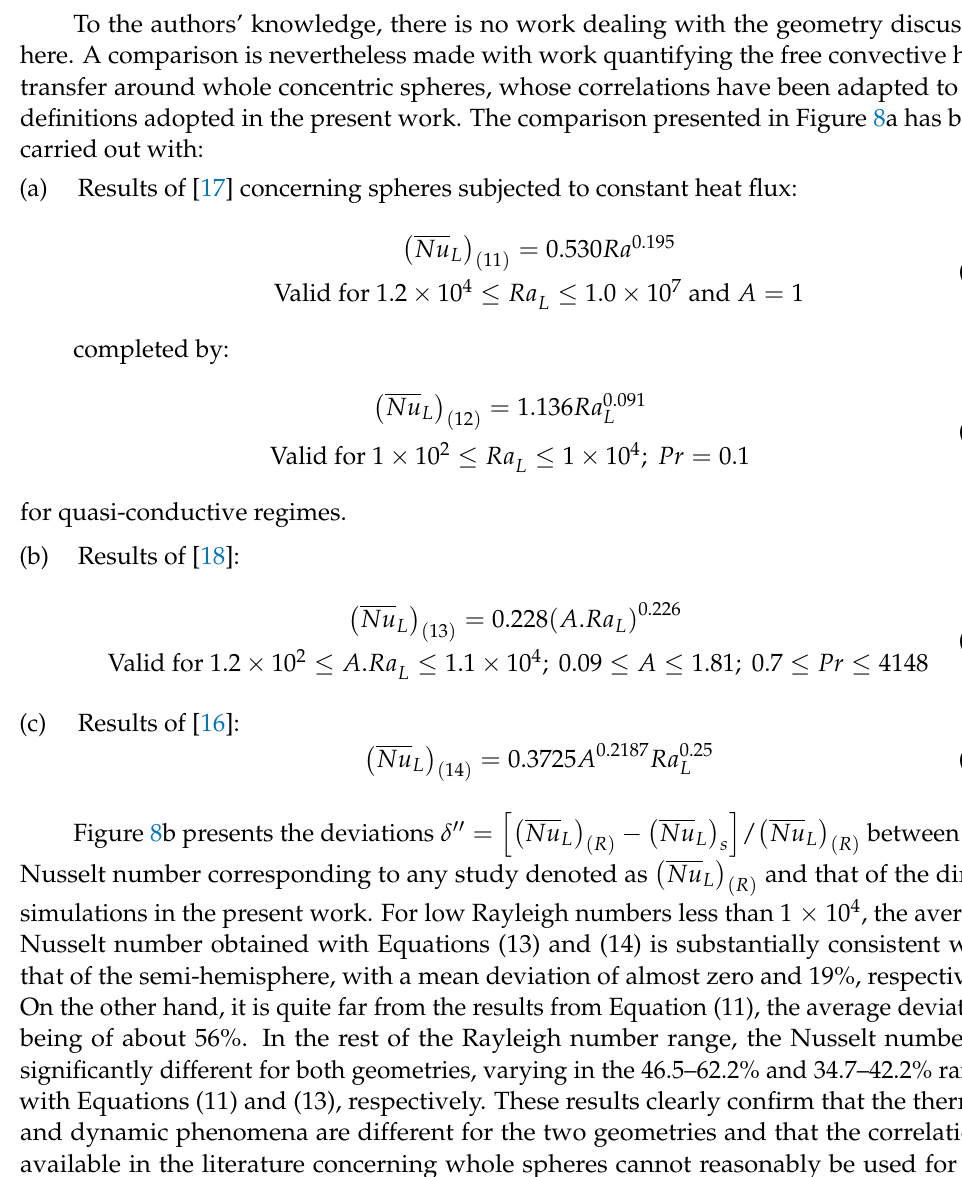
Figure 7. ( a ) Evolution of Nu L versus Ra (cid:0) (cid:1) (cid:0) (cid:1) Nu L Nu L / ( 10 ) s